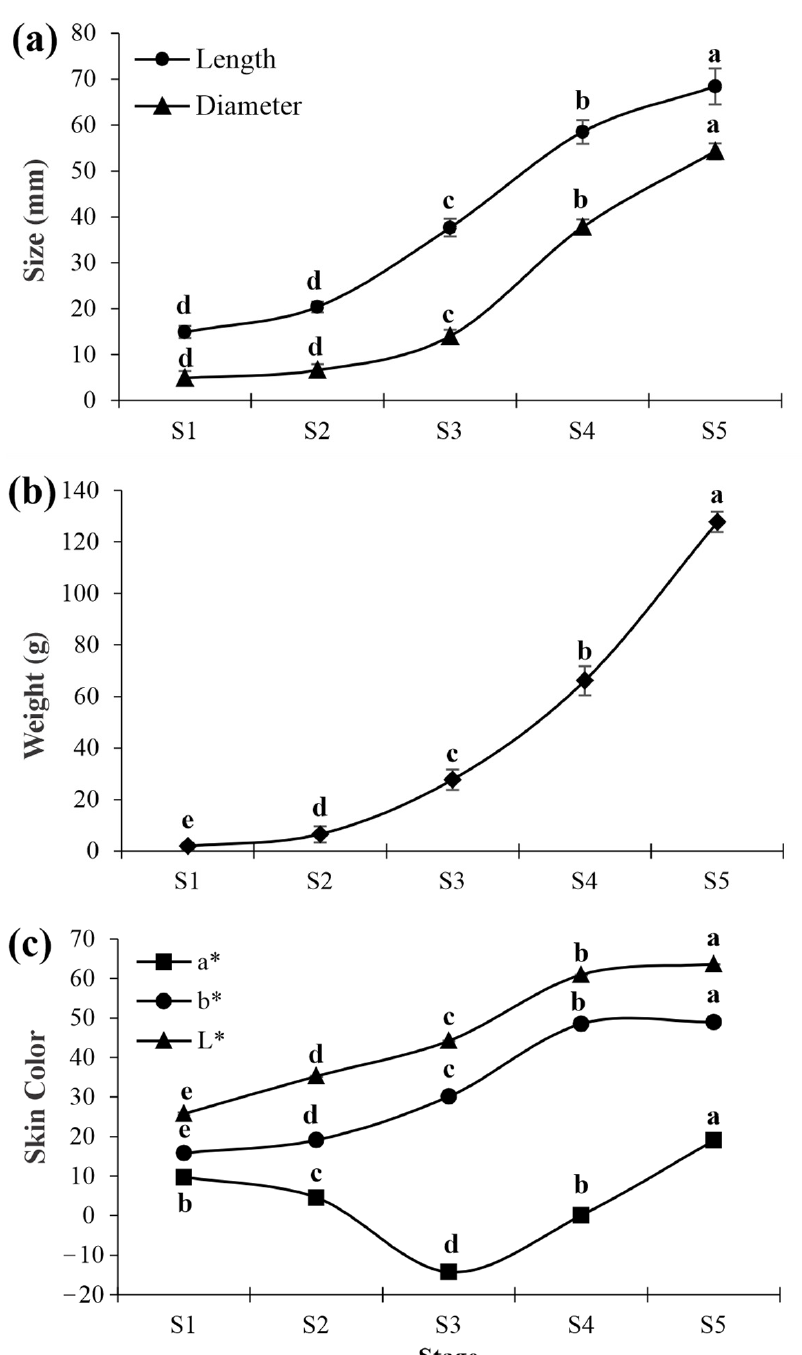
Figure 2. Length and diameter ( a ), weight ( b ), and skin color ( c ) of CCP 76 cashew pseudofruits in five stages (S1, S2, S3, S4, and S5). The means followed by different lowercase letters are significant using Tukey’s test ( p < 0.05). Vertical bars represent the standard error of the mean. L* (lightness) (dark to light), a* (green to red), and b* (blue to yellow).